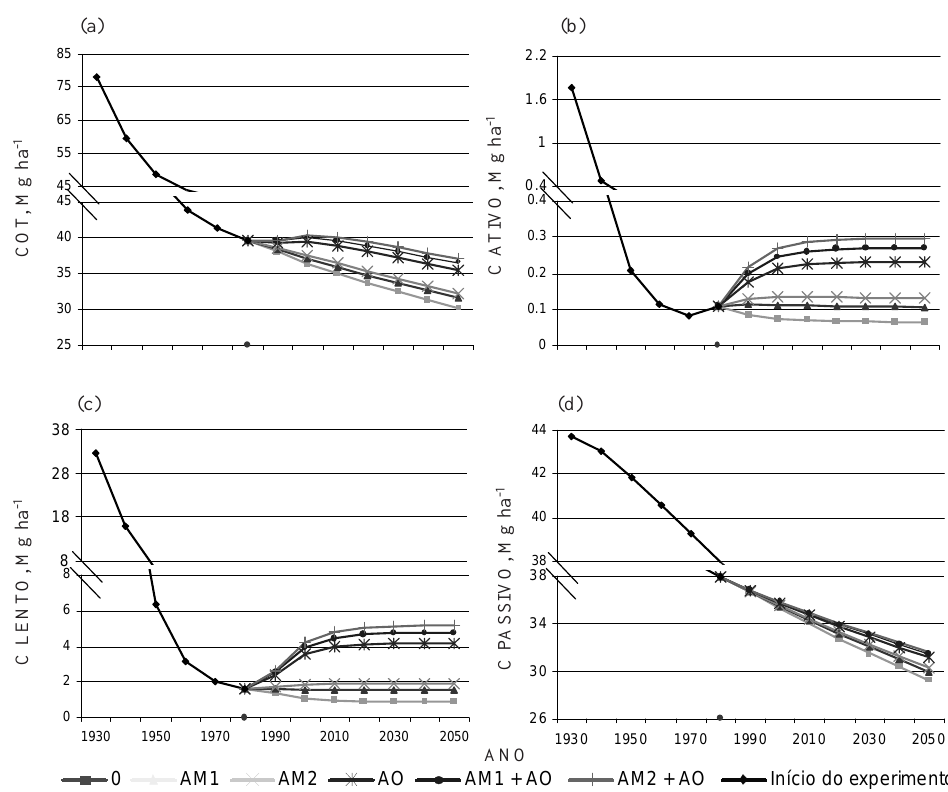
Figura 2. Estoques de carbono orgânico total (COT) (a) e de carbono nos compartimentos: ativo (b), lento (c) e passivo (d), simulados pelo modelo Century por meio do método indireto nos seguintes tratamentos: 0= testemunha; AM1 (adubo mineral 1) = 250 kg ha -1 de 4-14-8 + 20 kg N ha -1 em cobertura; AM2 (adubo mineral 2) = 500 kg ha -1 de 4-14-8 + 40 kg ha -1 de N em cobertura; AO = adubo orgânico, 40 m 3 ha -1 ; AM1 + AO e AM2 +